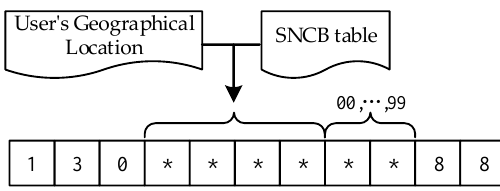
Figure 12. Construction schematic of the test set of mobile phone number.